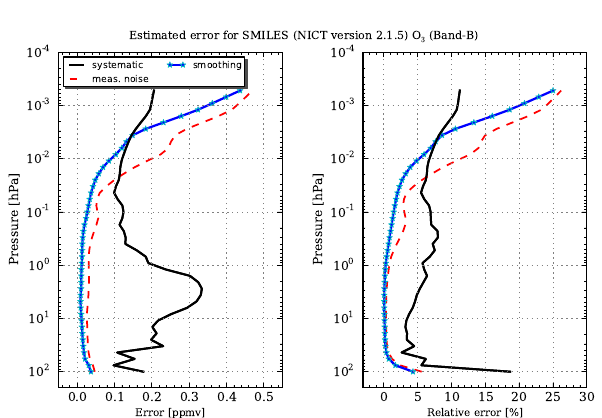
Fig. 4. Estimated systematic and random errors due to the model parameters and calibration error for the SMILES O 3 (Band-B) profile. Total systematic error is shown in a black profile. The red dashed profile represents the measurement noise error for a single scan, and the blue line with star symbols is the smoothing error. Total system- atic error is from Fig. 3.